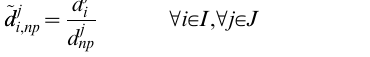
are samples i , np